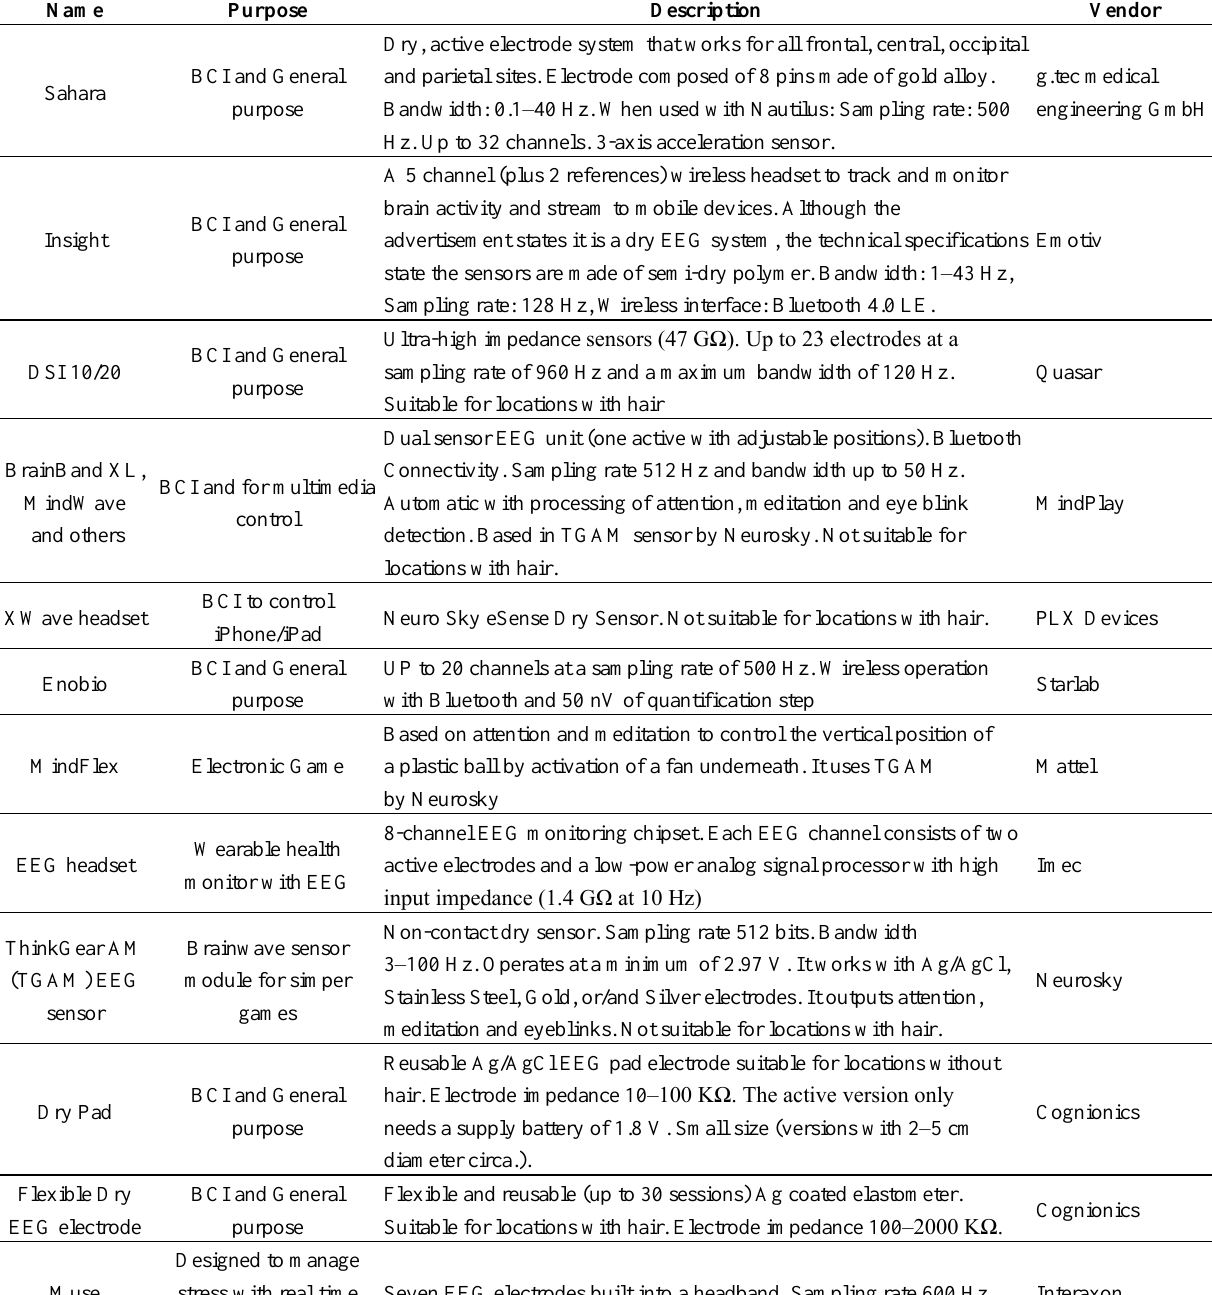
Table 2. Commercial EEG systems based on dry